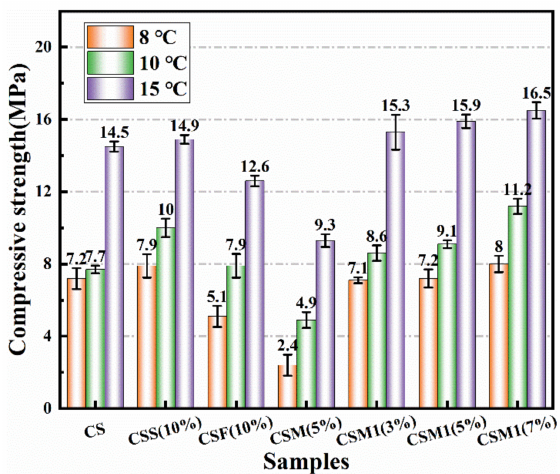
Figure 16. Compressive strength of cement stone after 24 h at 8 ◦ C, 10 ◦ C, and 15 ◦ C. Compared with CS, the compressive strength of CSM1 3% , CSM1 5% , and CSM1 7% cured at 15 ◦ C for 24 h increased by 5.5%, 9.7%, and 13.8%, respectively. This occurs